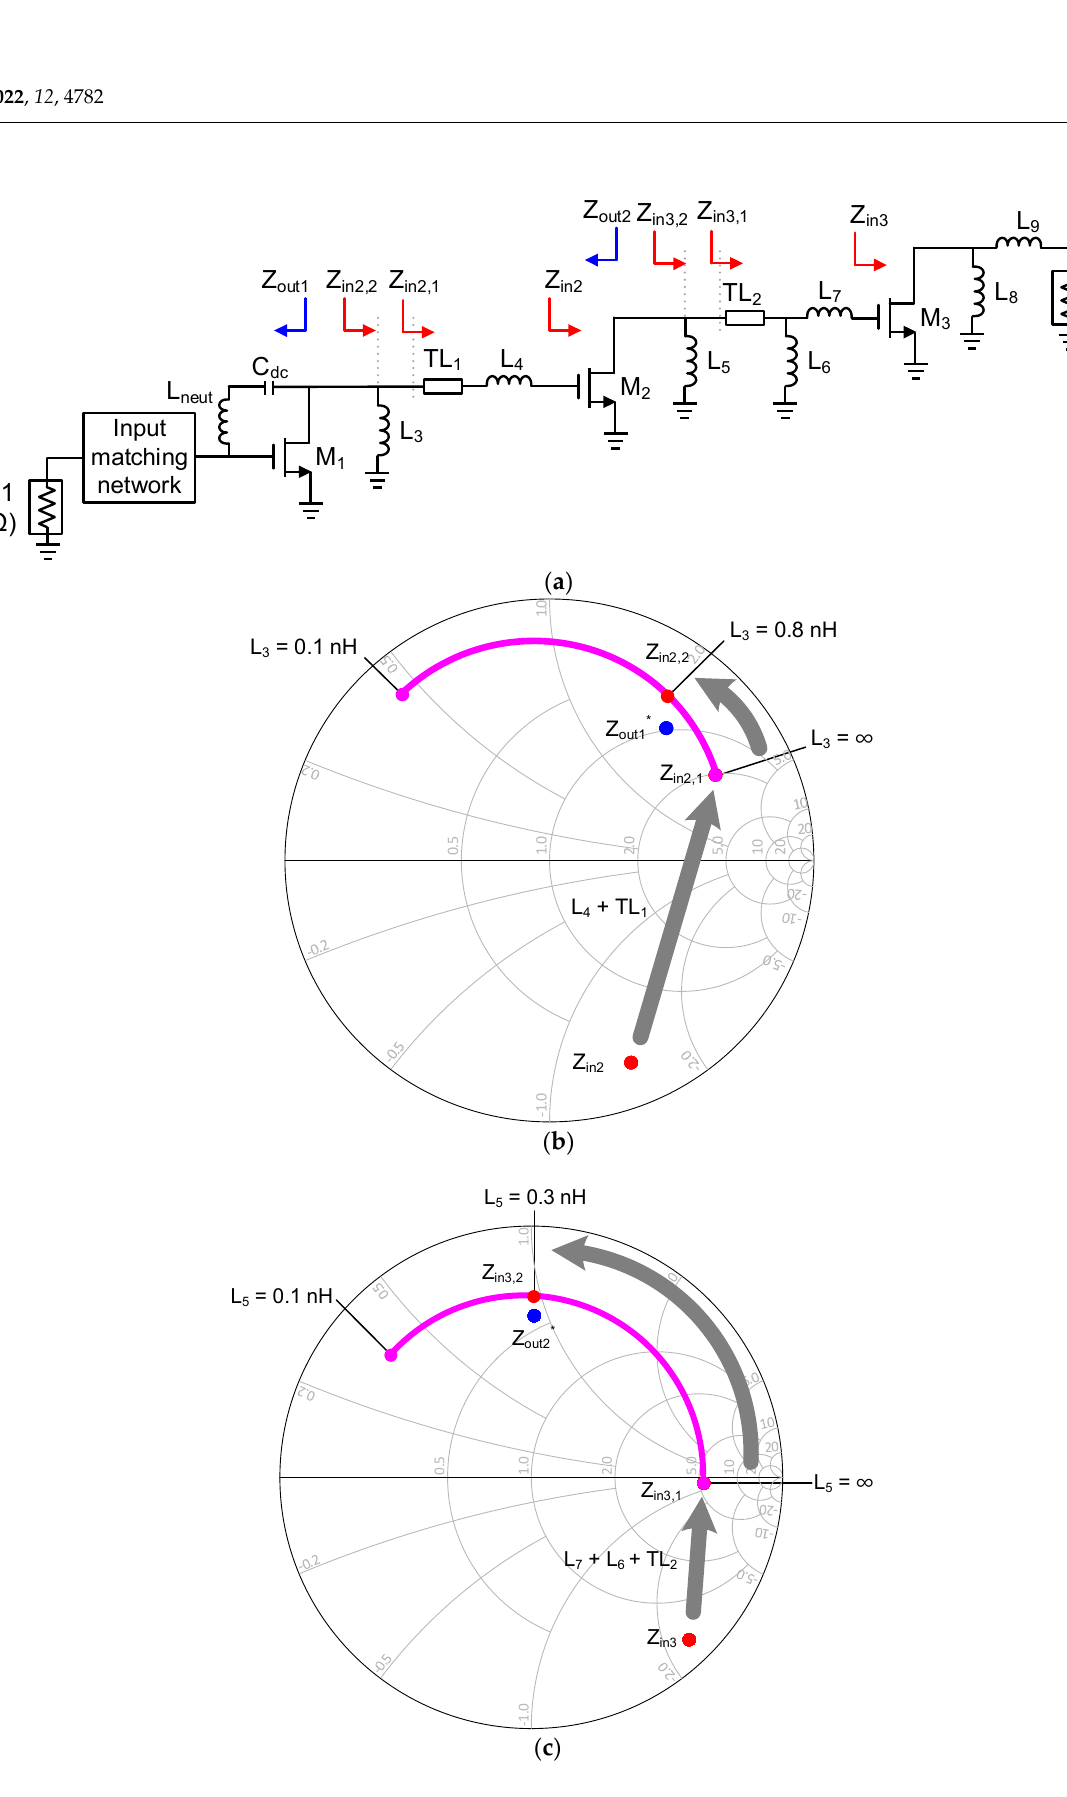
Figure 7. Interstage matching: ( a ) AC equivalent circuit of the amplifier; ( b ) first interstage matching at 42 GHz; ( c ) second interstage matching at 26 GHz.